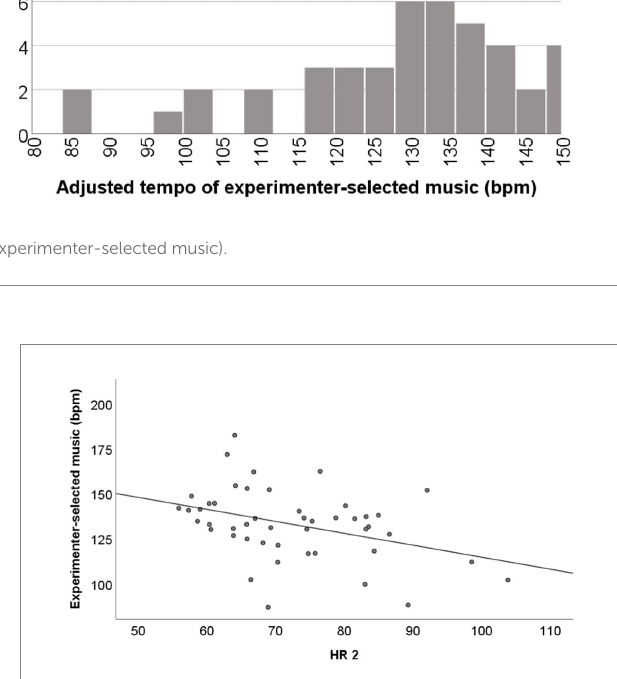
FIGURE 6 Experimenter-selected music against HR2 with regression